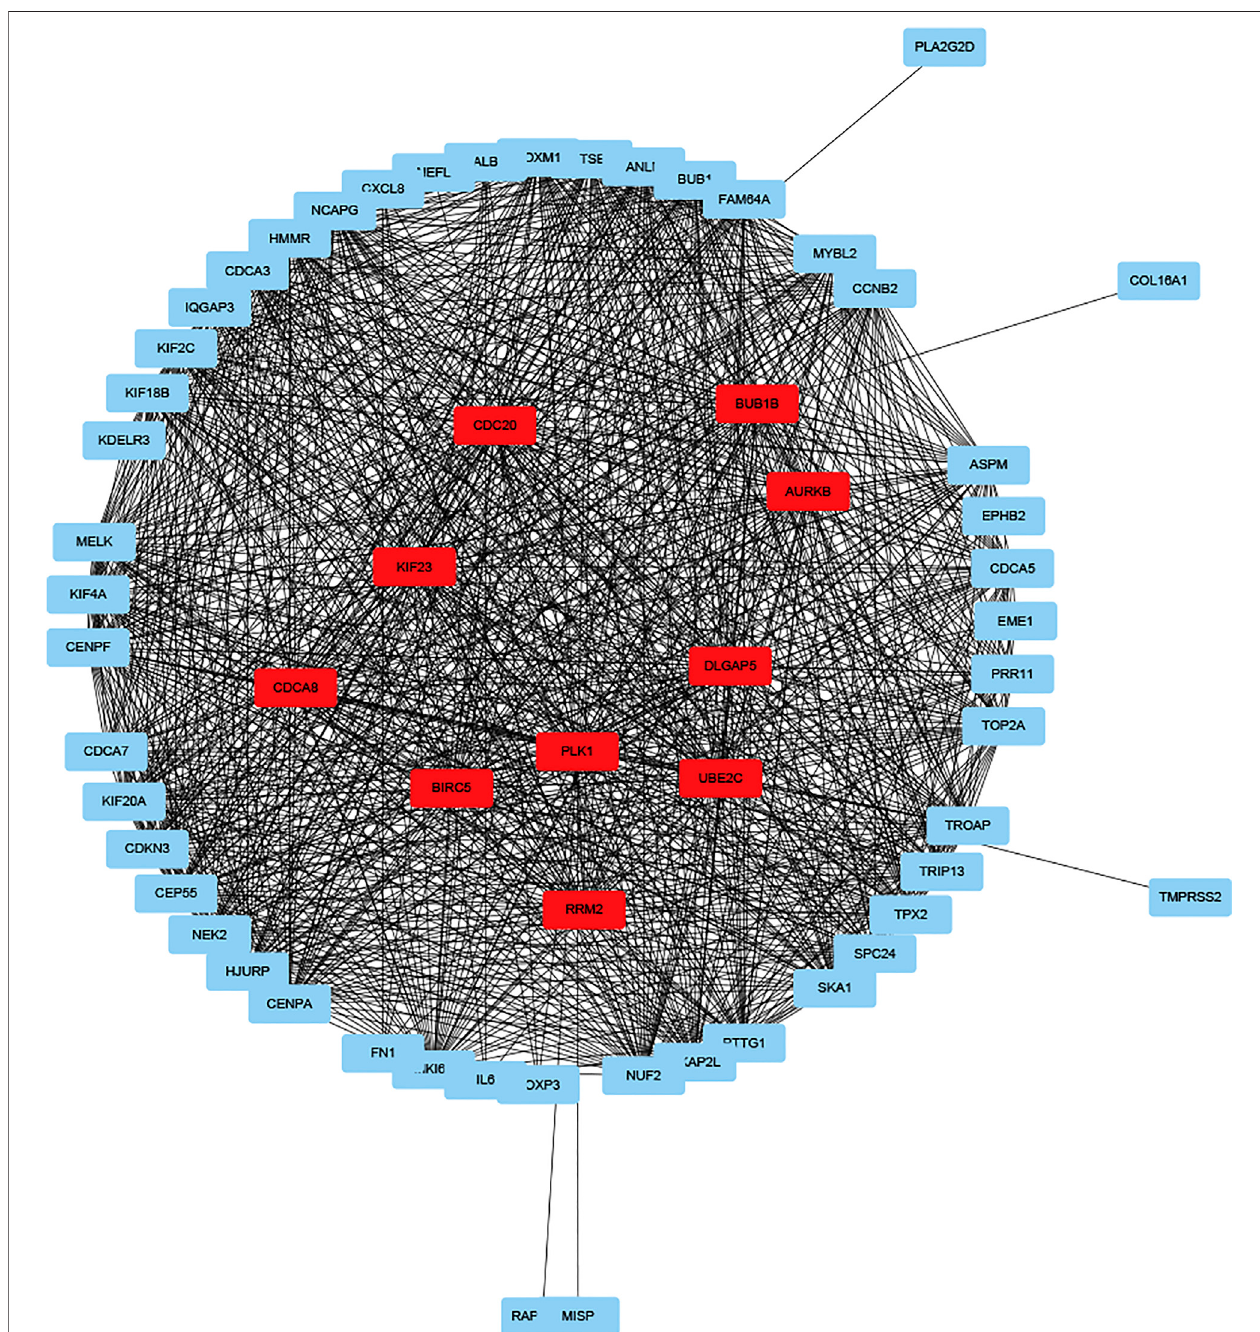
FIGURE 6 | Protein-protein interaction networks of